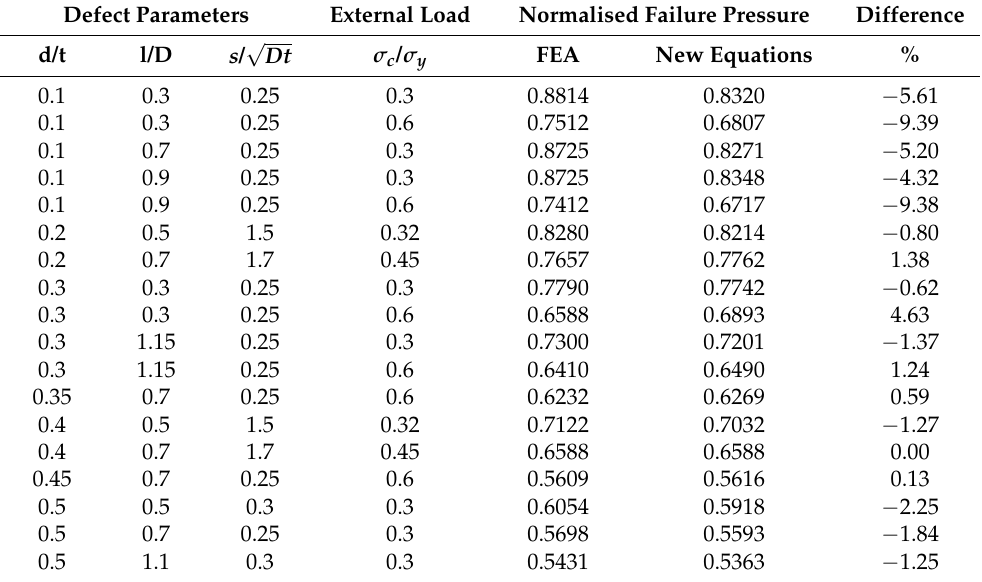
Table 11. Failure pressure predictions using FEA and predictions made based on the equations on unseen